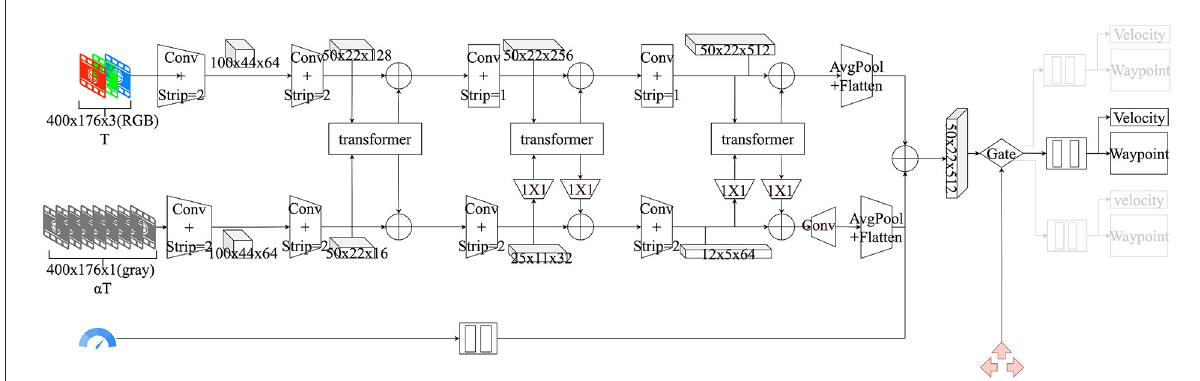
FIGURE3 Architecture of dual-flow network. The first row is the perception network using an RGB image as input, the second row is the motion network using a sequence gray image as input, and the third row presents the input of the velocity. T denotes the sampling rate of images per second, and α denotes the ratio of the image sampling rate of the perception network and motion